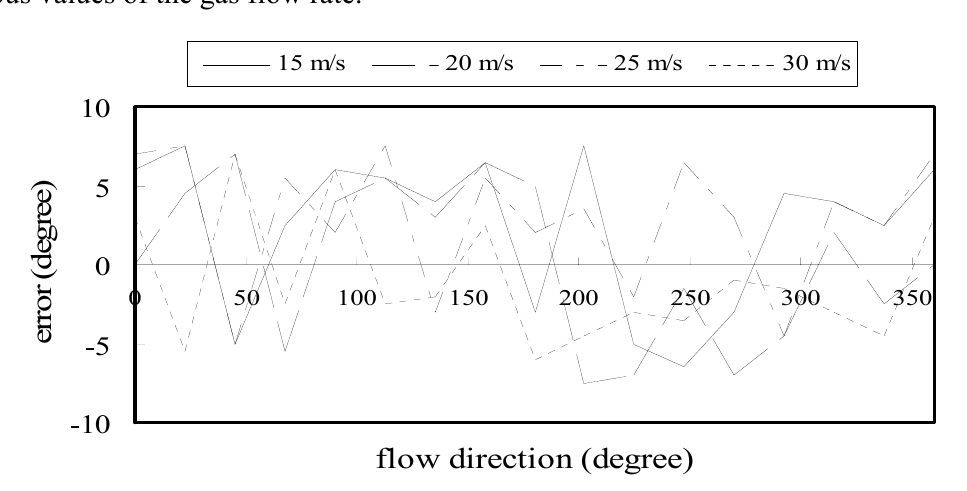
Figure 13. Measurement accuracy of flow-rate-compensated flow direction sensor at various values of the gas flow rate.